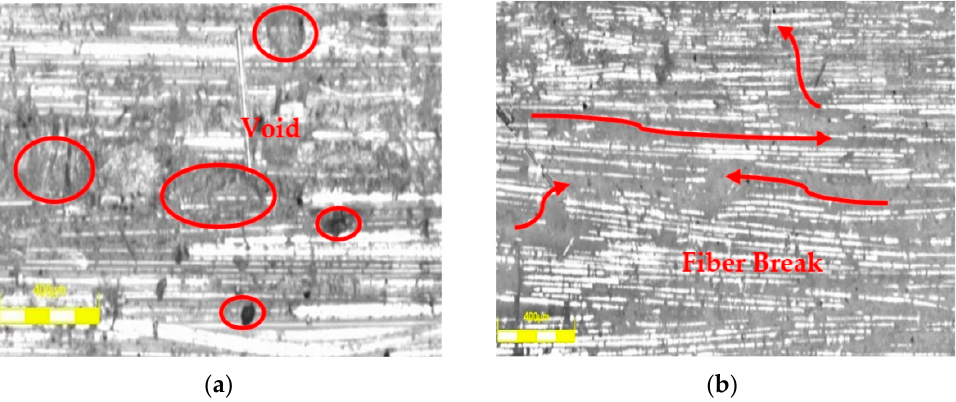
Figure 8. Microscopic images of group B: ( a ) N = 5385; ( b ) N = 8820.